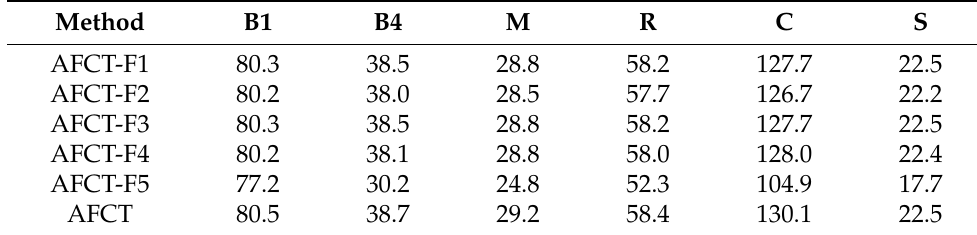
Table 3. Results from the different variants. All variants’ results reported after CIDEr-D